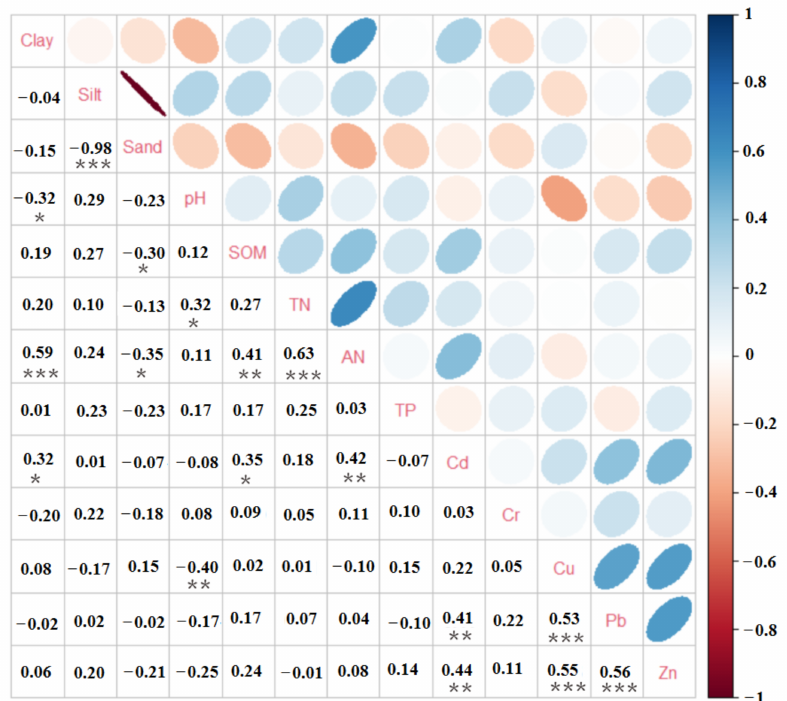
Figure 3. Correlation matrix of soil properties. The number indicate strong correlation (* p < 0.1 and ** p < 0.05) or significant correlation (*** p < 0.01).